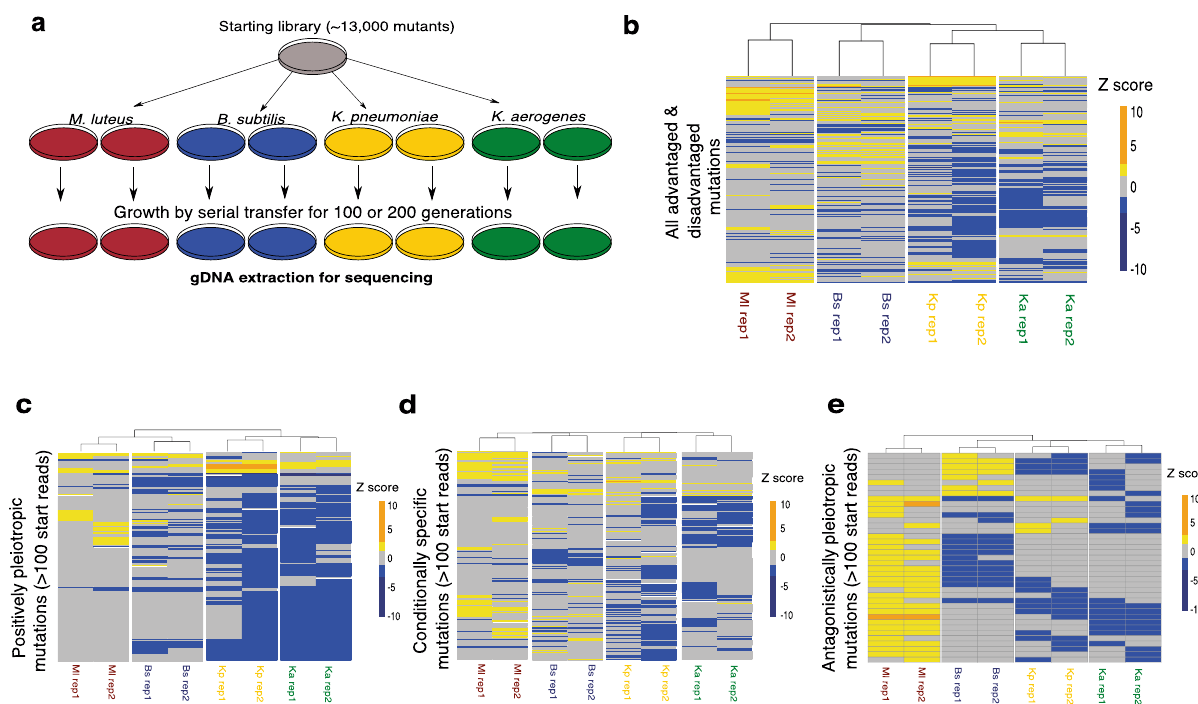
Fig. 4 Parallel genetic selections reveal most mutations result in prey-speci fi c effects. a Selection schematic. Cells from the mutant library were plated in duplicate in four parallel selections on the Gram( − ) bacterial species K. aerogenes and K. pneumoniae , and the Gram( + ) species B. subtilis and M. luteus . Cells were grown for either 100 generations ( B. subtilis , M. luteus , K. pneumonia selections) or 200 generations ( K. aerogenes selection) before being sequenced by REMI-seq to quantify the relative abundance of every mutant remaining in the pool (Supplementary Figs. 3, 4 and Supplementary Data 2). b Patterns of behaviour across the different bacteria for mutants with a growth phenotype show an overall pattern of prey speci fi city. z -scores of mutants that were identi fi ed as either advantaged (yellow = mean z > 1.5, >100 normalised reads in both selection endpoint replicates) or